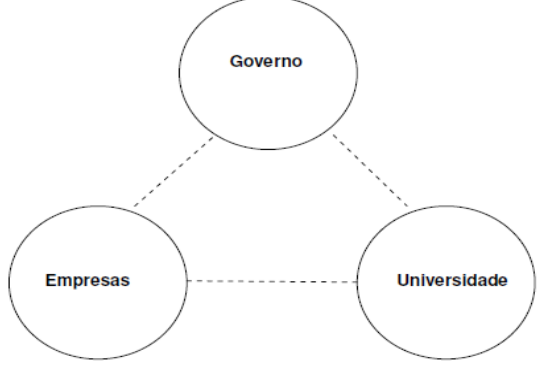
Figura 2. Modelo laizzez-faire de relações entre